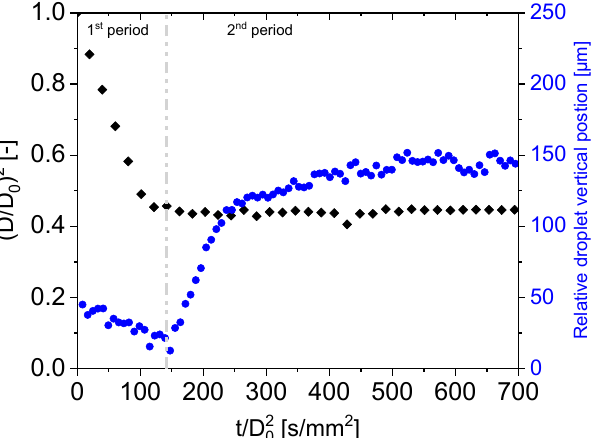
Figure 5. Experimental drying curve plotted in terms of the dimensionless droplet surface for 15% ( w / w ) initial PEG concentration, the air drying temperature was set at 50 ◦ C. The droplet’s relative vertical position in the acoustic field is plotted in blue.